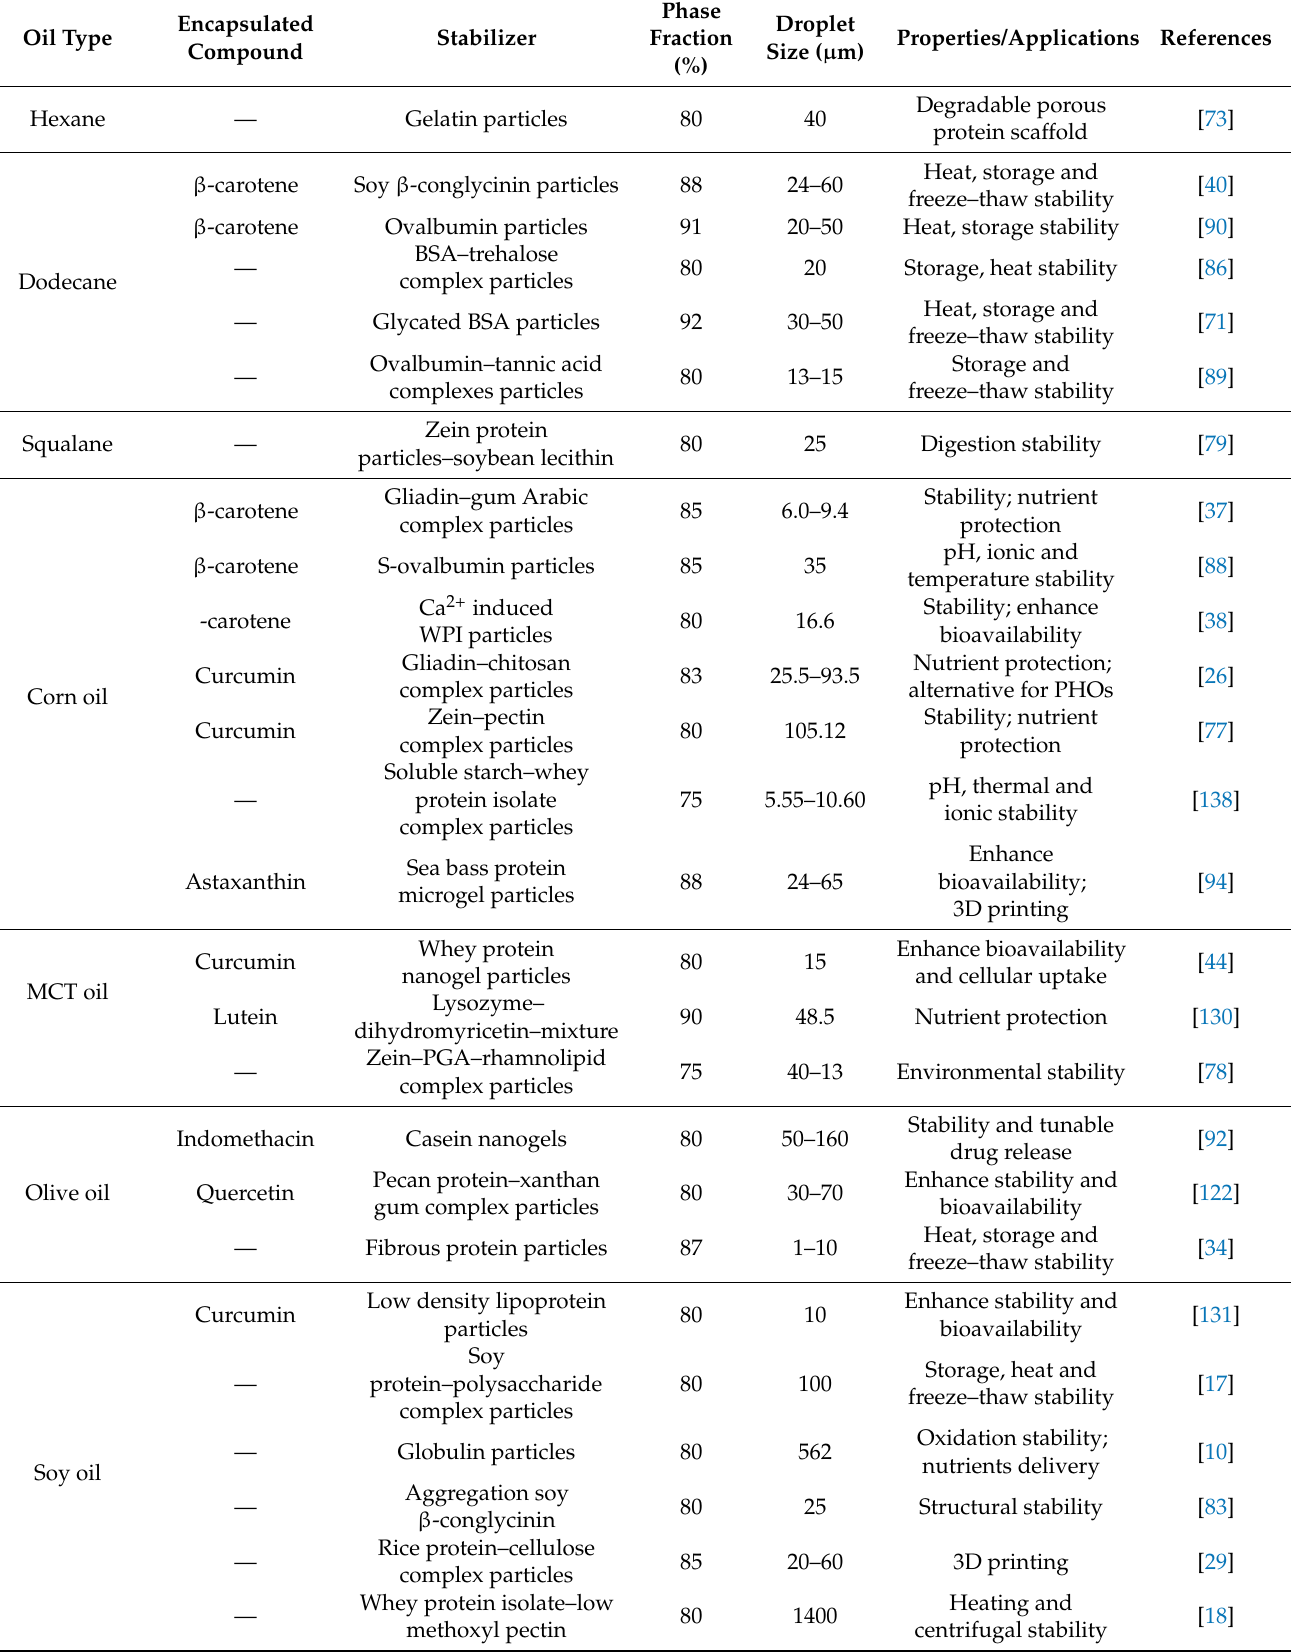
Table 2. Composition and functional properties of